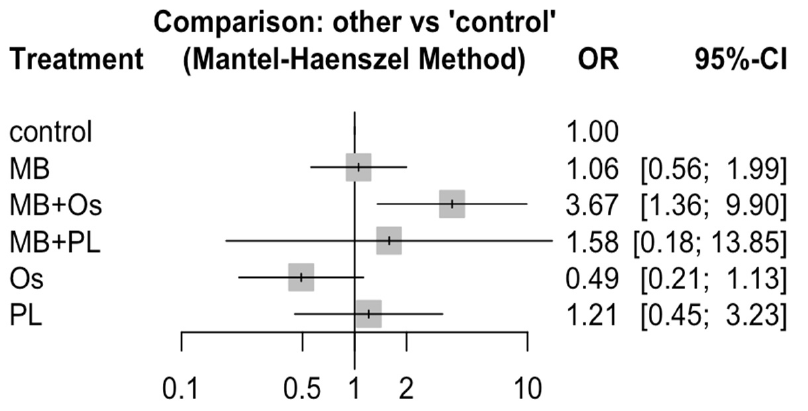
Figure 5. Forest plot of healing success using GTR techniques (odds ratio) compared to control group.